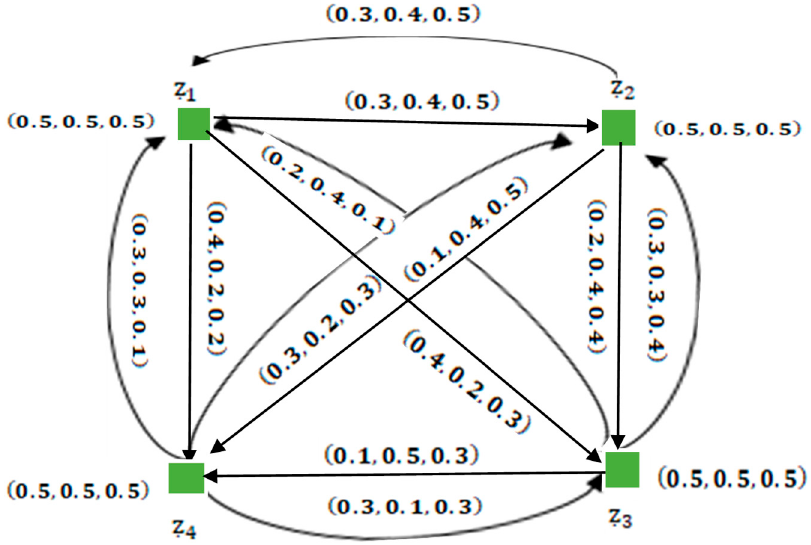
Figure 25. Directed network with single-valued neutrosophic information.